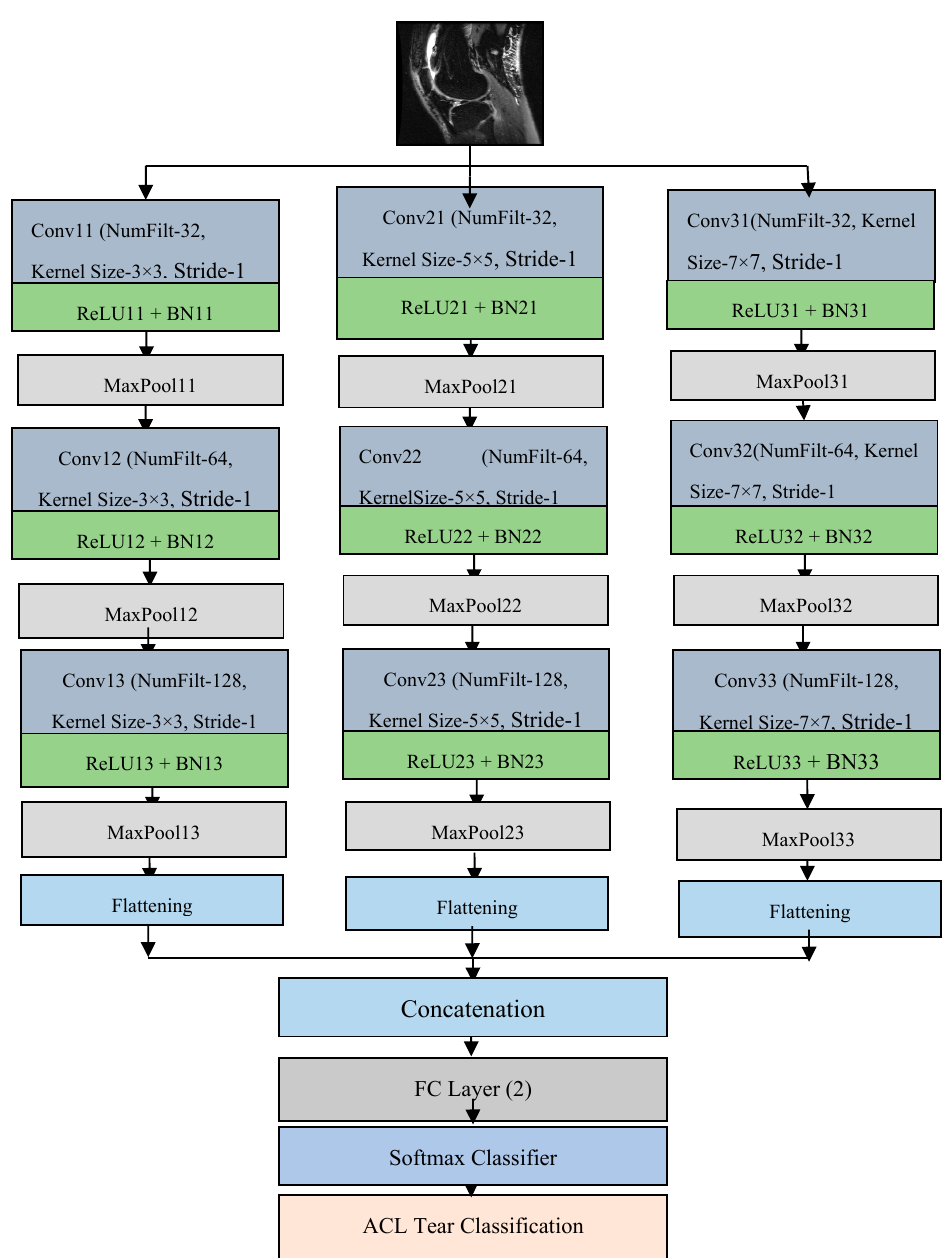
Figure 1. Flow diagram of proposed DCNN-based ACL tear detection.